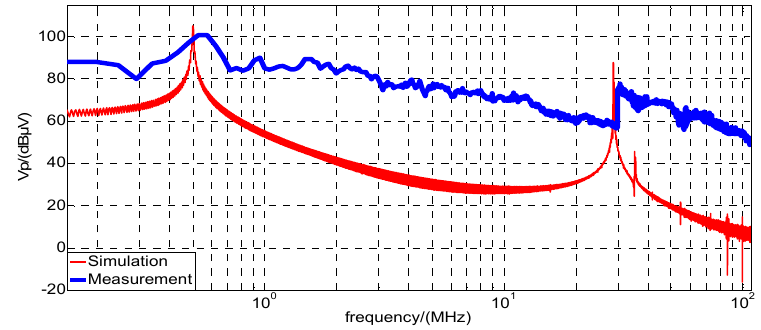
Figure 12. Comparison of measurement and simulation.